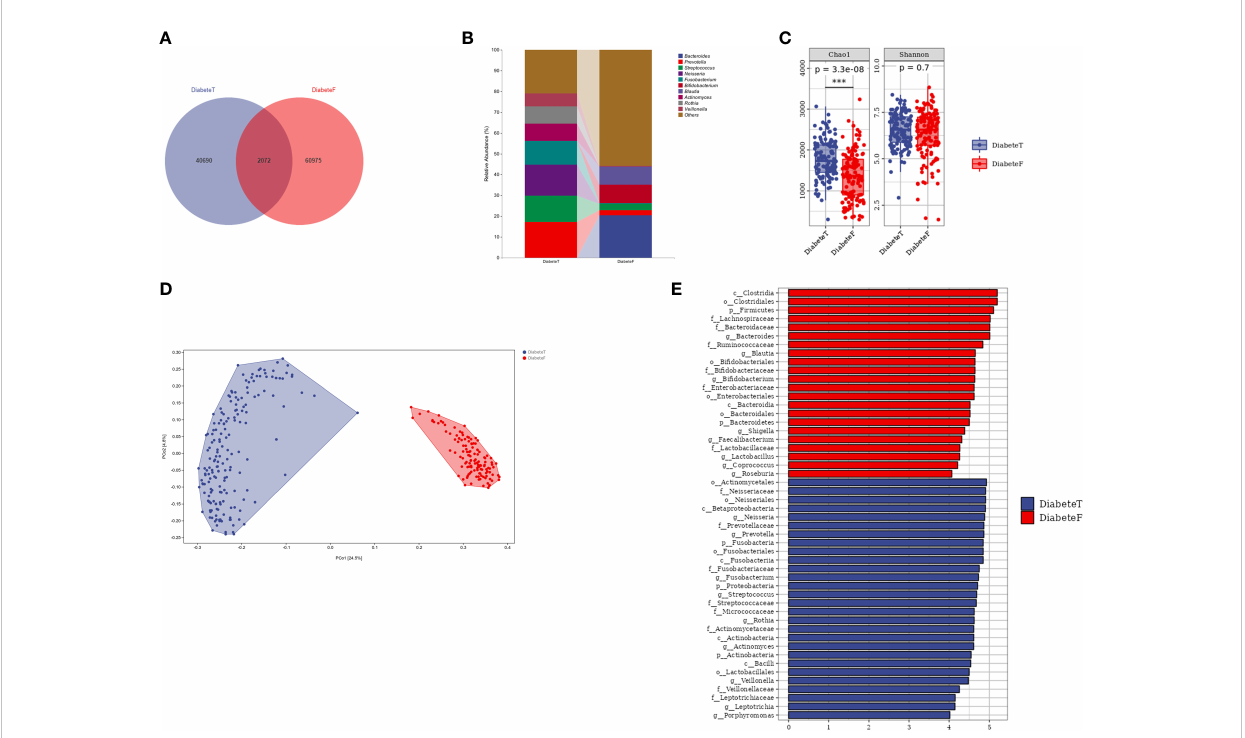
FIGURE 4 Difference between oral fl ora and intestinal fl ora in patients with T2DM. (Figure (A) is the Venn diagram of oral and intestinal microbiota at the ASV level. Figure (B) is the microbiota in both groups (top 10 genera). Figure (C) is the results of a diversity. Figure (D) is the result of the PeoA analysis. Figure (E) is the LEISe analysis results (the LDA threshold is 4). T represents the tongue-coating microbiota sample, and F represents the intestinal microbiota samples.). *** represents